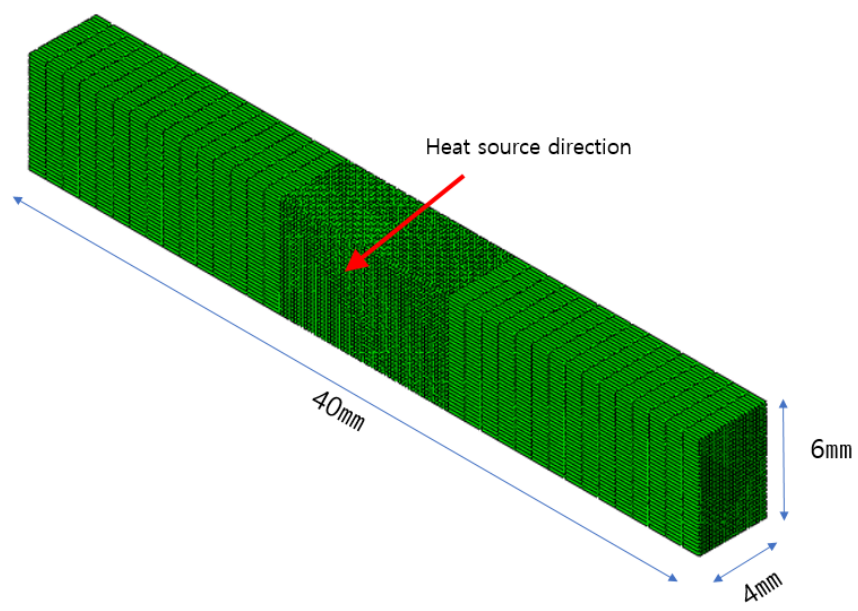
Figure 8. Simplified model.